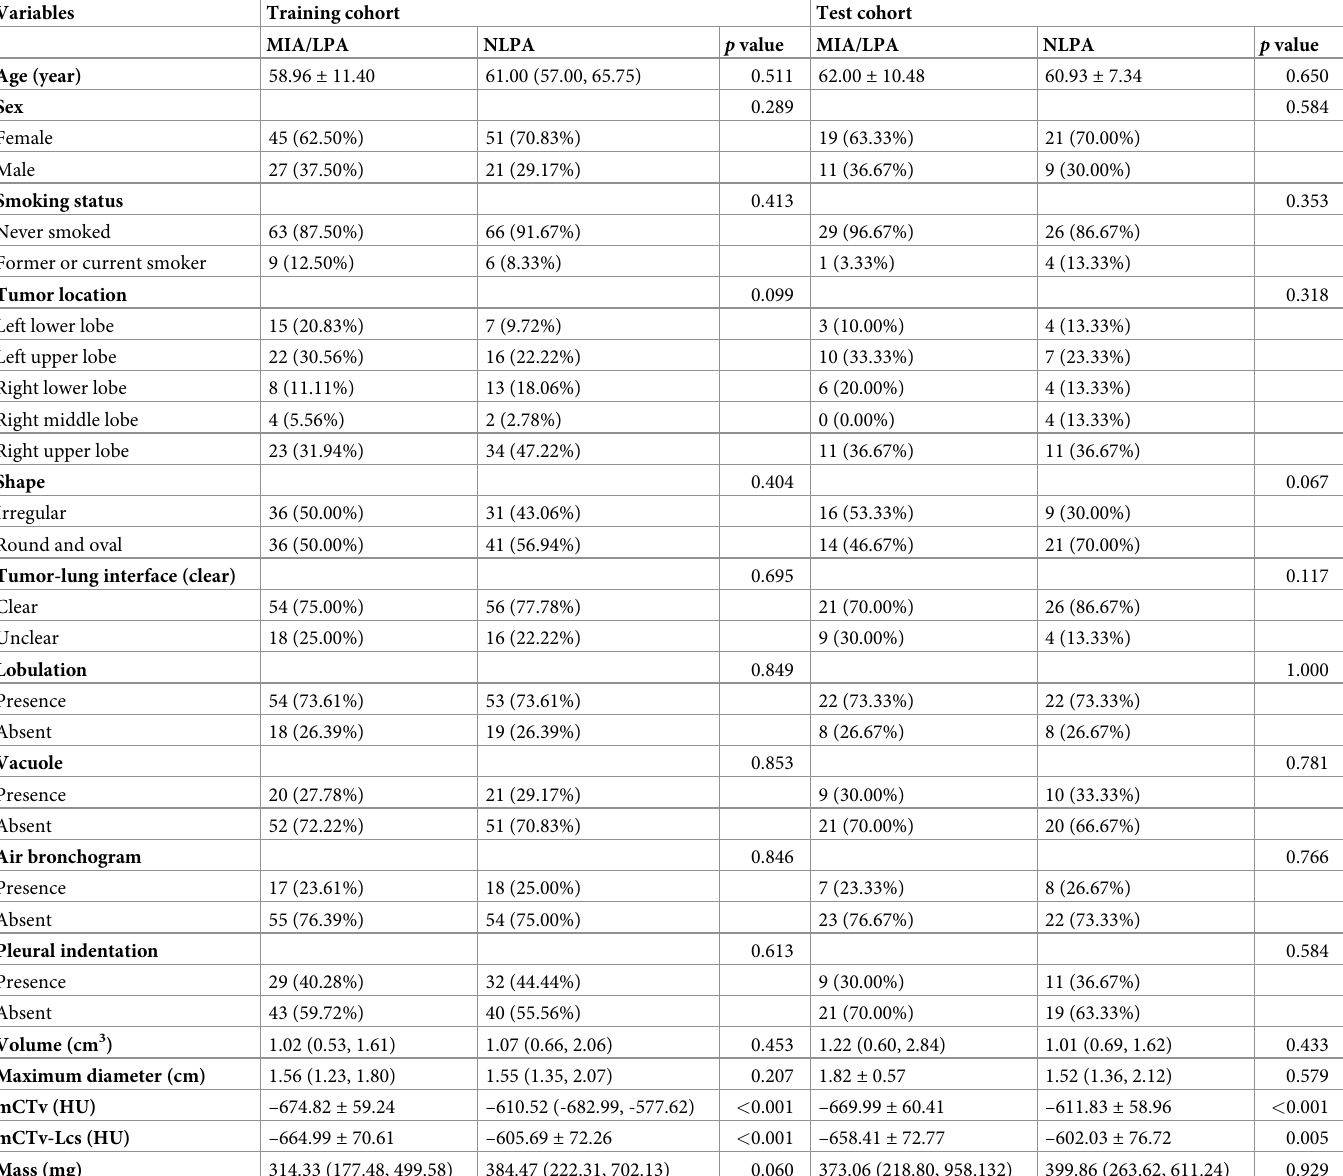
Table 1. Comparison of variables between MIA/LPA and NLPA in the training and test